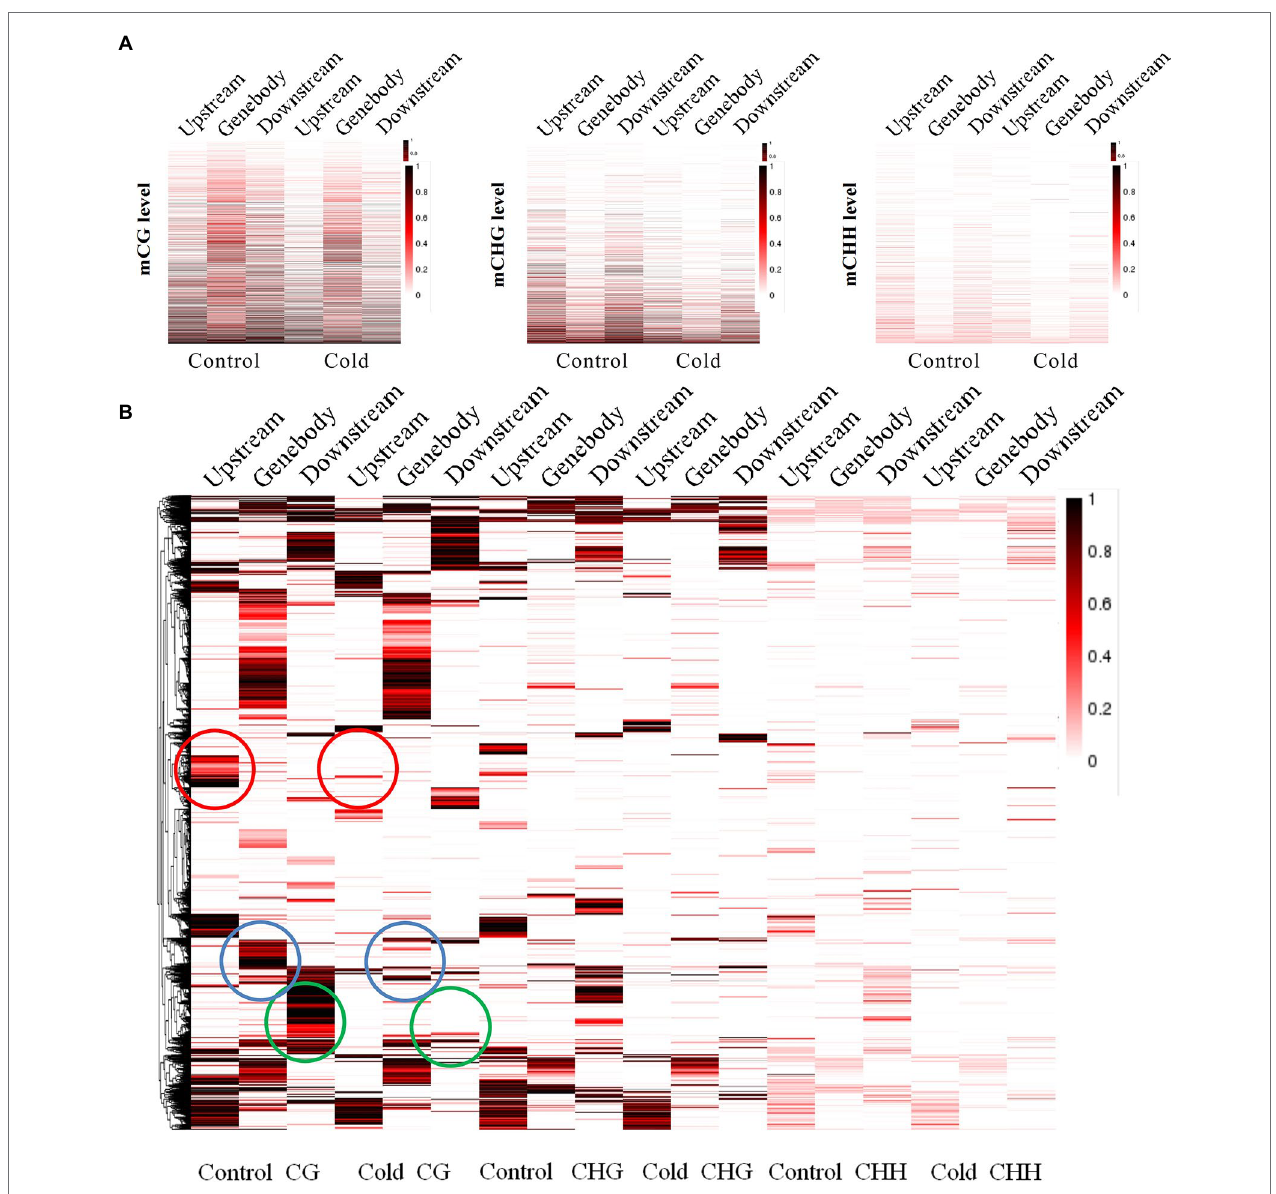
FIGURE 4 | Distribution and clustering of the methylation of differentially expressed genes. (A) The methylation levels of mCG, mCHG and mCHH in control and cold-treated samples are shown by a heat map (upper panel). The box plot shows CG, CHG, and CHH methylation levels at hyper-DMRs. Dark horizontal line, median; edges of boxes, 25th (bottom) and 75th (top) percentiles; whiskers, minimum and maximum percentages of DNA methylation (lower panel). (B) Heat map of gene clustering representing the methylation levels of differentially expressed genes at various gene regions. The methylation level is indicated by the depth of the